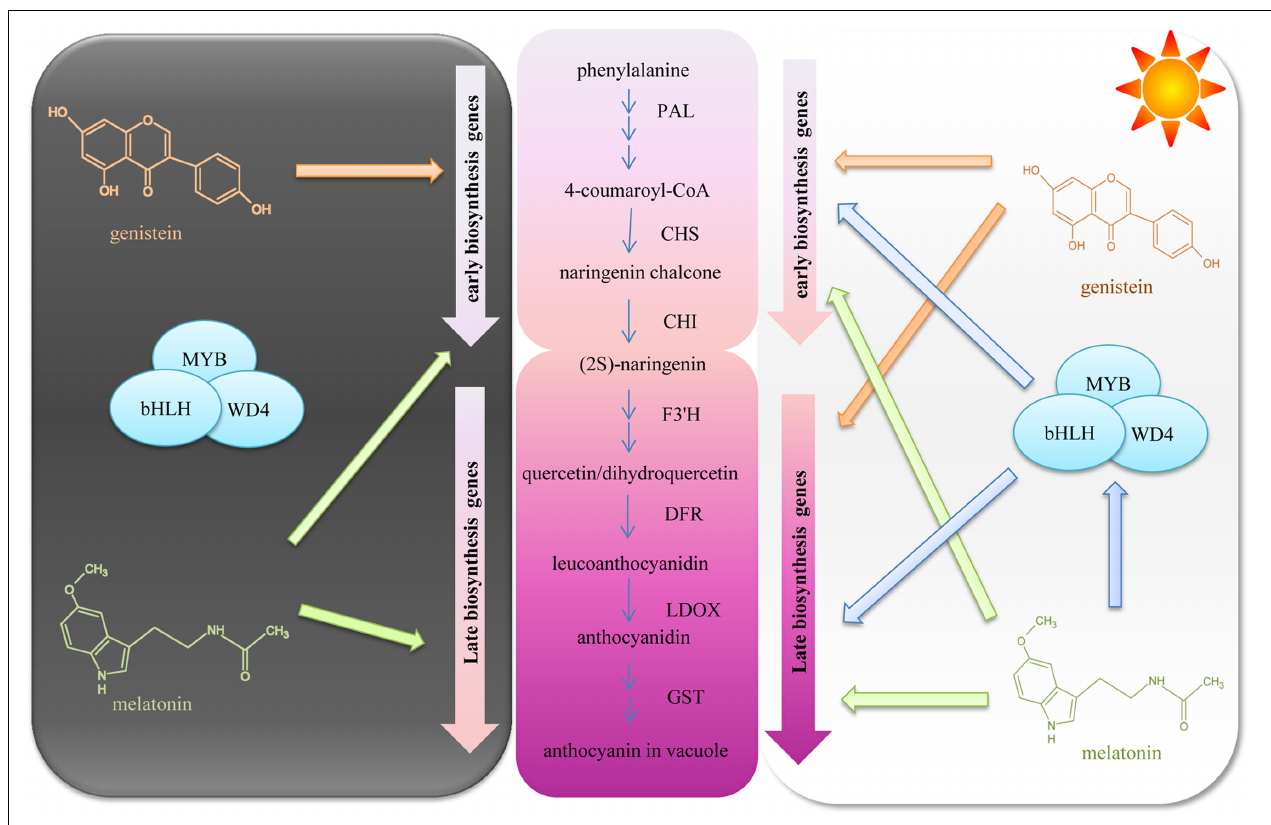
FIGURE 8 | The mechanisms of genistein regulating anthocyanin biosynthesis in dark and light